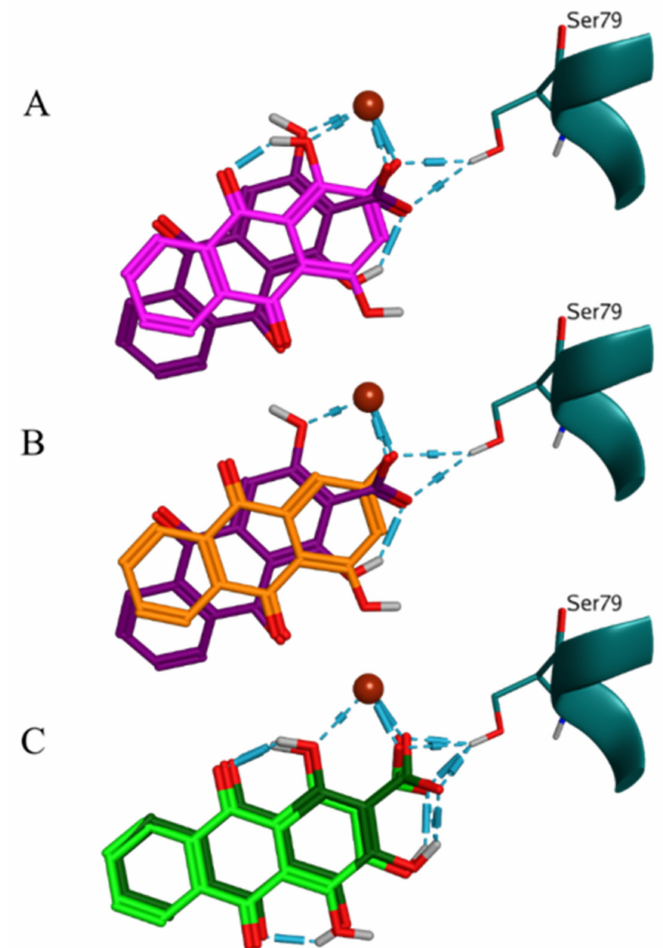
Figure 7. Binding modes in the DNA topoisomerase IV complex. ( A ) comparison between the ligand-receptor interactions of munjistin (BM1, violet) and purpurin (BM1, magenta); ( B ) comparison between the ligand-receptor interactions of munjistin (BM1, violet) and xanthopurpurin (BM1, orange); and ( C ) comparison between two poses of pseudopurpurin in